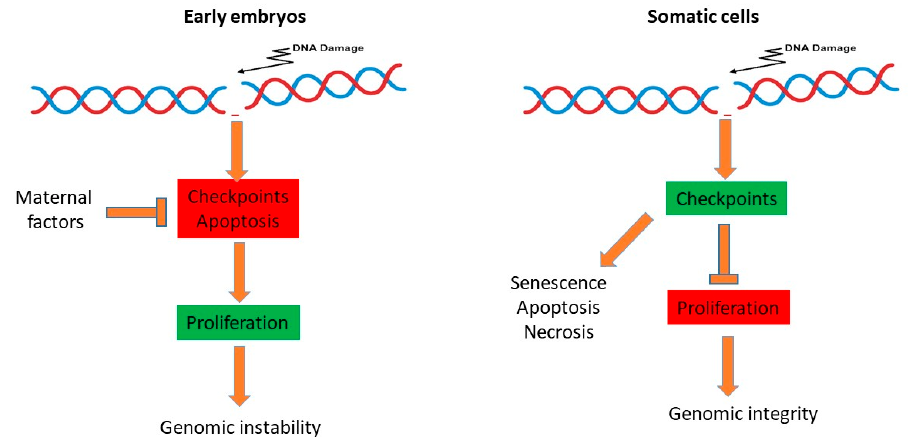
Figure 3. Differences in the regulation of proliferation in embryos versus somatic cells. Inefficient checkpoint activation, suppression of apoptosis and a high contracted cell cycle promotes rapid and unchecked proliferation in the early embryo leading to the generation of a certain degree of genomic instability. In somatic cells, DNA damage is readily monitored by checkpoints that slow down cell proliferation to facilitate DNA repair, and as such preserve genome integrity, leading, when necessary, to permanent cell cycle arrest (senescence) or cell death (apoptosis, necrosis).